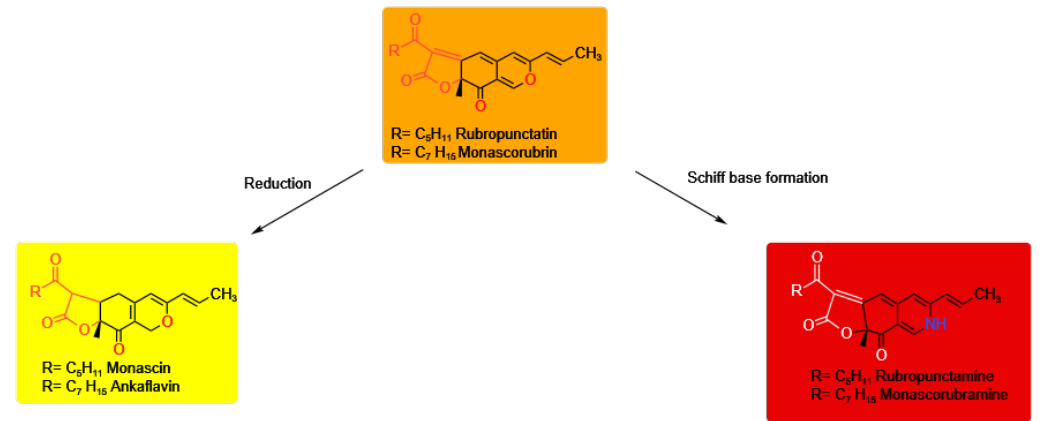
Figure 3. Hypothetical pathway of Monascus pigment and citrinin biosynthesis. The figure was reproduced following Woo and Chen [161,162].